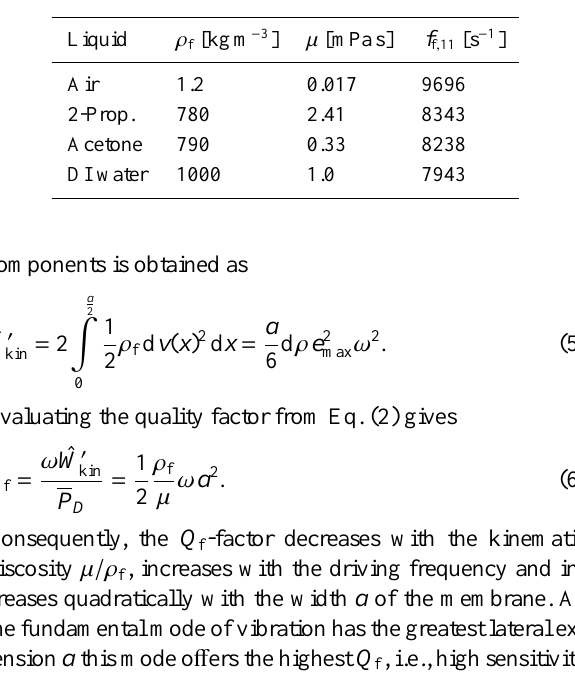
Table 1. Parameters of test